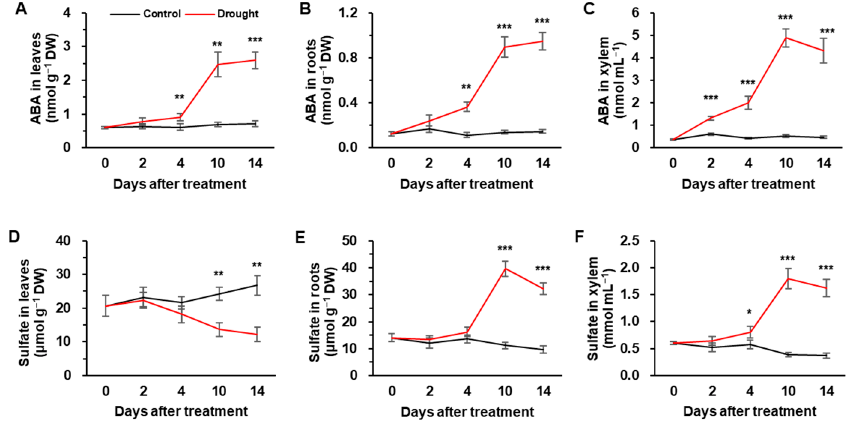
Figure 2. Changes in the concentration of ABA ( A – C ) and sulfate ( D – F ) in leaves ( A , D ), roots ( B , E ), and xylem ( C , F ) of well-watered (control) or drought-stressed plants for 14 days. The black and red lines indicate control and drought stress, respectively. Data represented as means ± S.E. for n = 4. Asterisks indicate a significant difference between well-watered and drought-stressed plants: * p < 0.05, ** p < 0.01, *** p < 0.001.